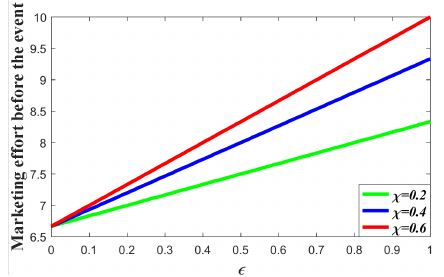
Figure 3. Impacts of χ on marketing decision.